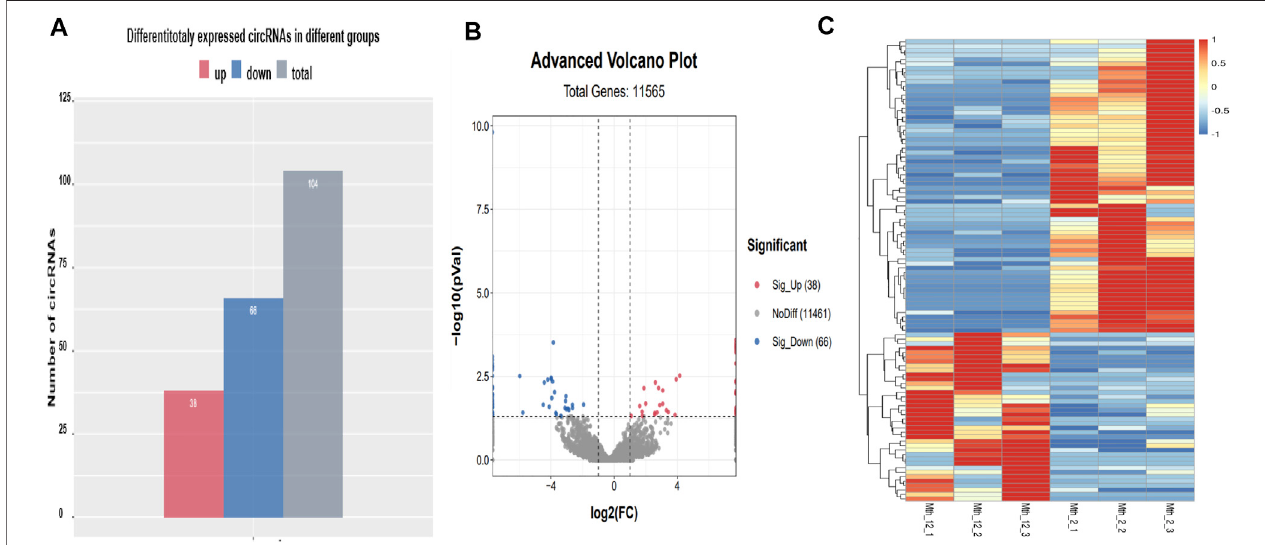
FIGURE 3 | DifferentiallyexpressedcircRNAs. (A) AhistogramofdifferentiallyexpressedcircRNAs; (B) AscatterplotofdifferentiallyexpressedcircRNAs; (C) Acluster heat map of differentially expressed circRNAs. The abscissa is the sample, and the ordinate is the differentially expressed screened-out genes. Different colors indicate differentgeneexpressionlevels.Thecolorchangesfrombluetowhitetored,withredindicatinghighlyexpressedgenesandblueindicatinggeneswithlowexpressionlevels.